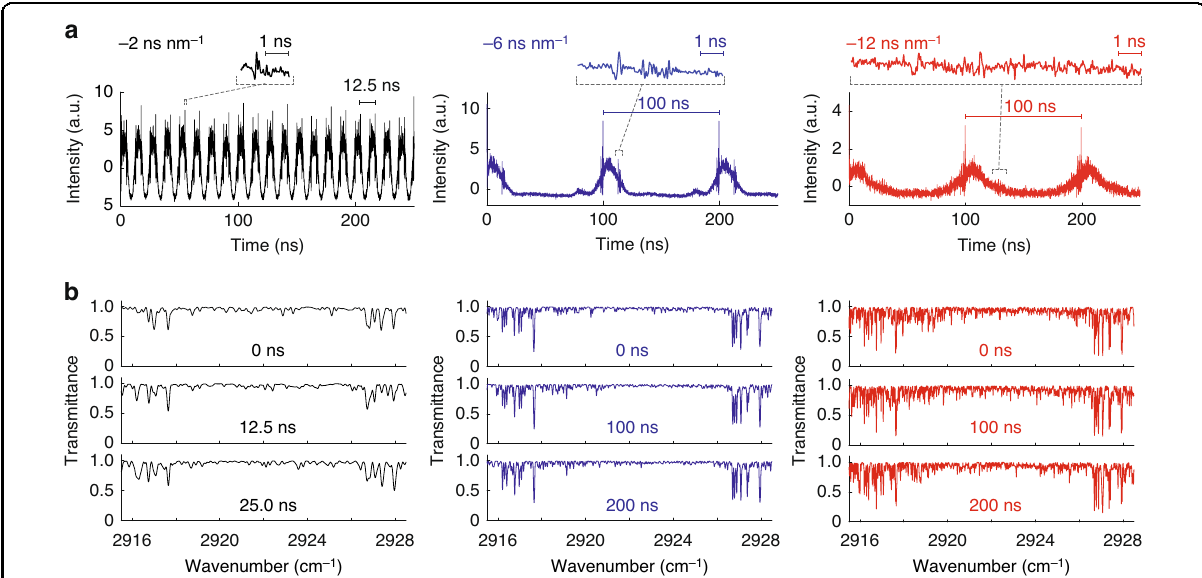
Fig. 3 High-speed broadband MIR spectroscopy of gas-phase CH 4 molecules with upconversion TSIR. a Continuously measured TSIR spectra at a rate of 80 MSpectra s − 1 with a 10-km DCF (total dispersion of − 2 ns nm − 1 ) (black), 10 MSpectras − 1 with a 30-km DCF (total dispersion of − 6 ns nm − 1 ) (blue), and 10 MSpectras − 1 with a 60-km DCF (total dispersion of − 12 ns nm − 1 ) (red). The insets show enlarged views of a part of the spectra. b Single-shot transmittance spectra retrieved by the GD algorithm measured at 80 MSpectra s − 1 with a 10-km DCF (black), 10 MSpectra s − 1 with a 30-km DCF (blue), and 10 MSpectra s − 1 with a 60-km DCF